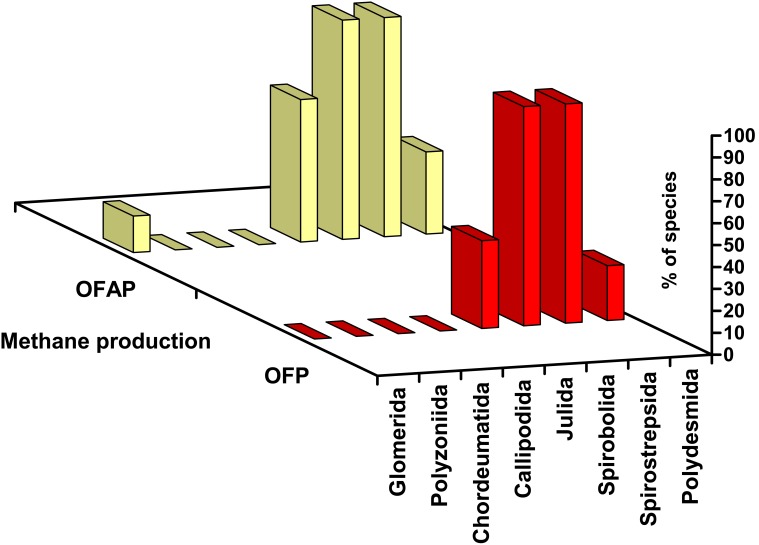
The distribution of methane-positive species among millipede orders.The red row of columns (OFP) is based on all tested species classified as either obligatory or facultative producers, and the yellow row (OFAP) includes obligatory, facultative, and accidental producers.